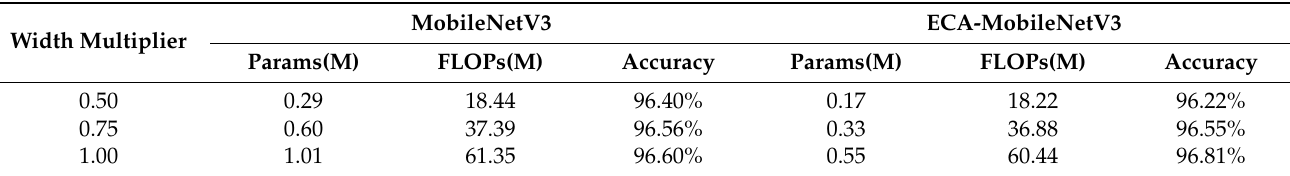
Table 7. Algorithmic complexity comparison for different-width multipliers on Beijing–Tianjin–Hebei airport cluster